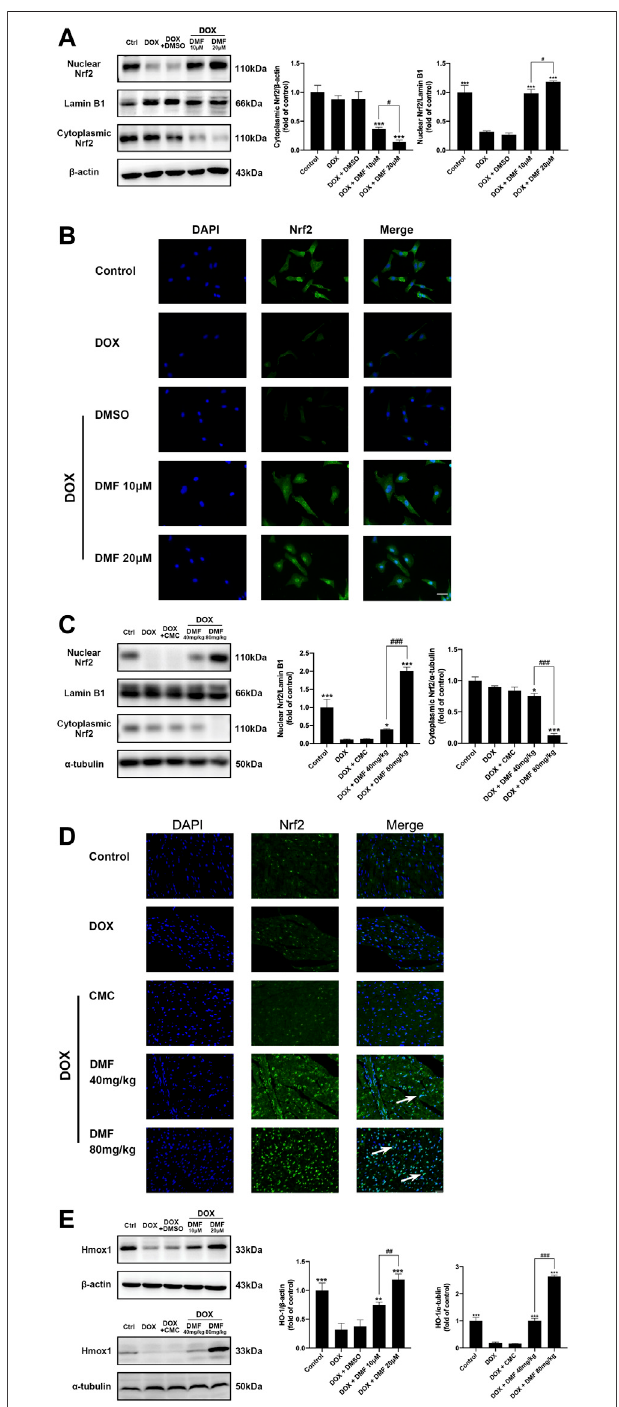
FIGURE5| EffectofDMFonNrf2signalinginNRCMsandratsafterDOX treatment. (A) Representative WB images and quantitative analysis of nuclear and cytoplasmic Nrf2 expression in NRCMs. β -actin and Lamin B1 were served as cytoplasmic or nuclear internal controls, respectively ( n = 5). (B) Location of Nrf2 in NRCMs using Immuno fl uorescence ( n = 5, scale bar = 25 μ m). (C) Representative WB images and quantitative analysis of nuclear and cytoplasmic Nrf2 expression in rats. α -tubulin and Lamin B1 were served ( Continued )